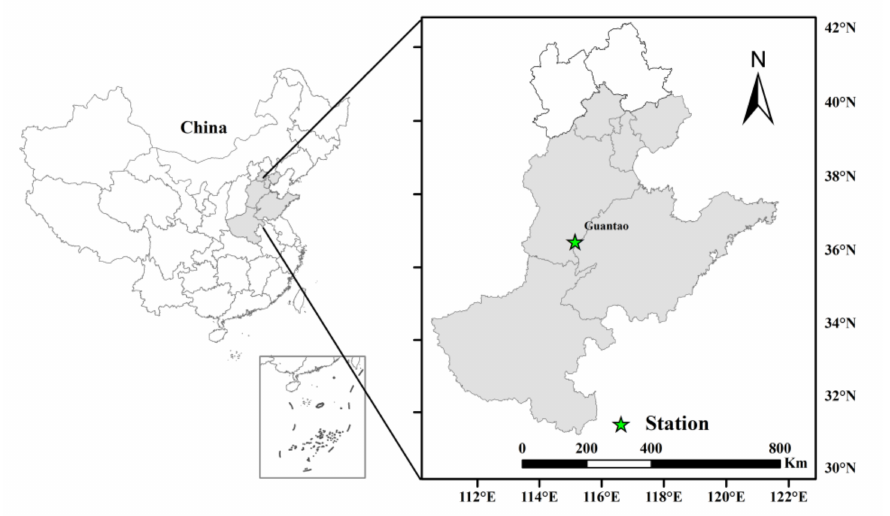
Figure 1. Location of the Huang–Huai–Hai (HHH) Plain in China ( left ) and of the experimental site within the HHH Plain ( right